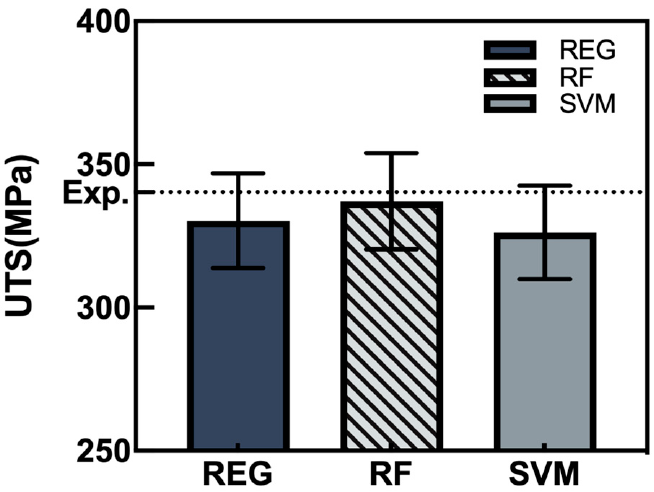
Figure 14. Predicted and experimental results at optimal parameter setting.